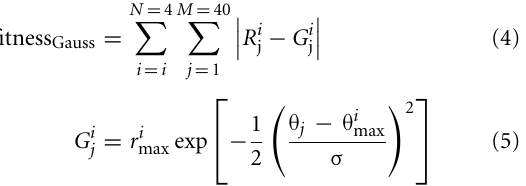
Table 1 | Range of allowable values for parameters optimized by the automated parameter tuning